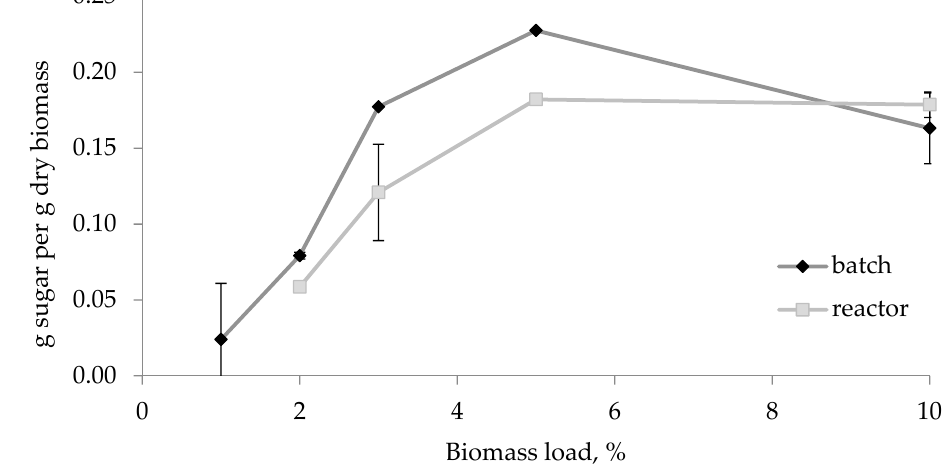
Figure 2. The impact of mixing and the overall reactor system setup on hydrolysis efficiency at various substrate and constant enzyme loading rates. Standard deviation represents the average from three separate test runs. Table 2. Fermentable sugar yields (g reducing sugar per g dry biomass) at systems with variable solid loadings and variable final enzyme concentrations.